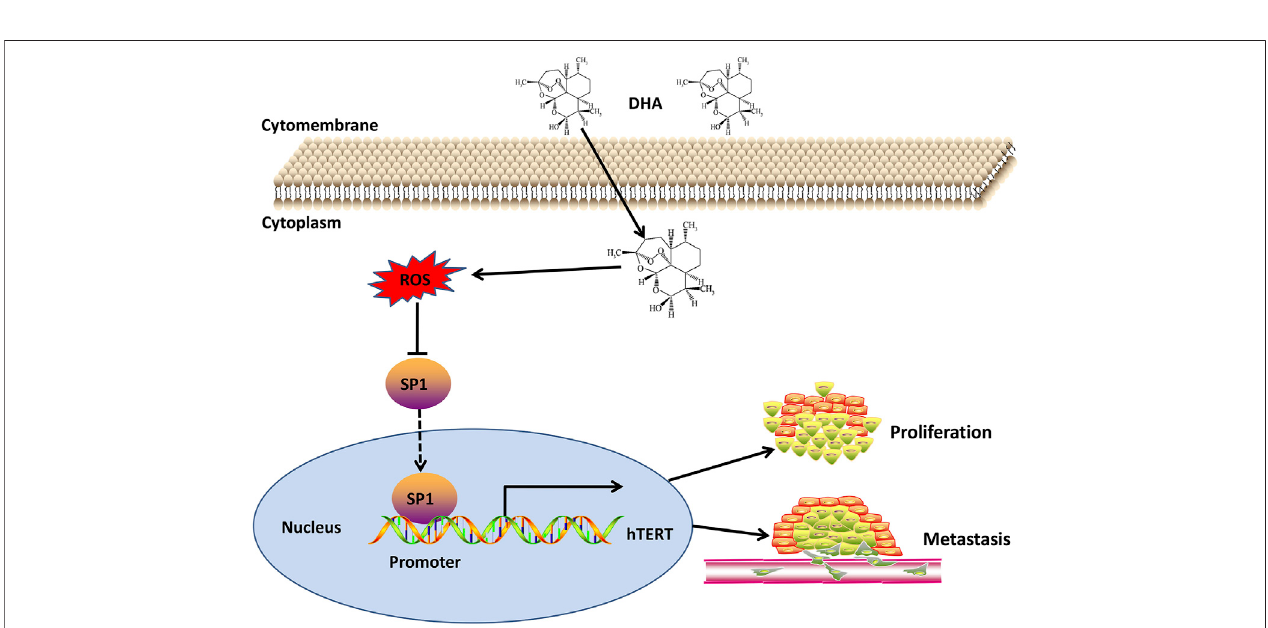
FIGURE 7 | Schematic diagram of the mechanism of DHA against esophageal cancer through ROS/SP1/hTERT axis.